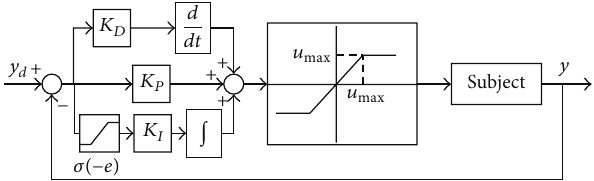
Figure 3: The schematic of the saturated controller using nonlinear sliding manifold equation